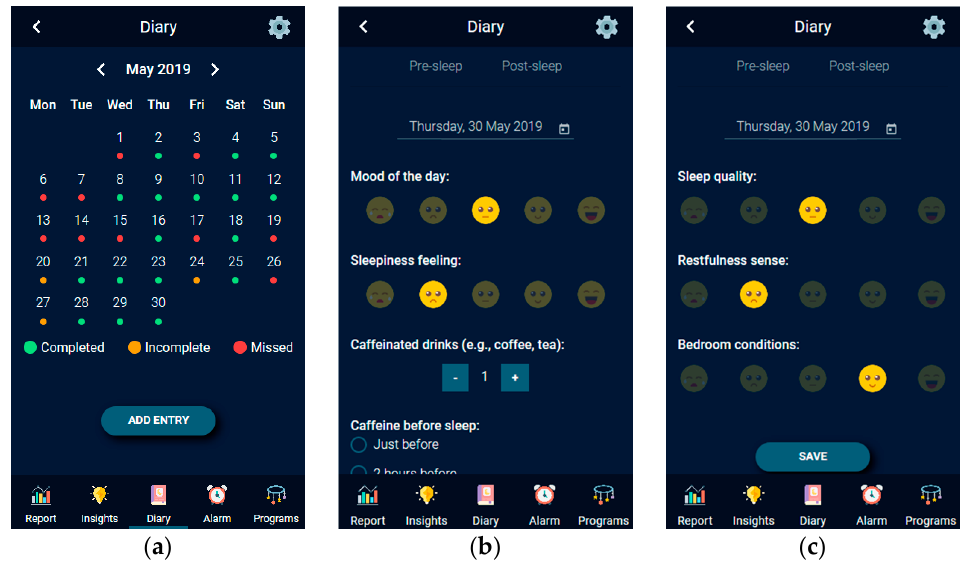
Figure 15. ( a ) Diary, ( b ) Pre-sleep Diary, and ( c ) Post-sleep